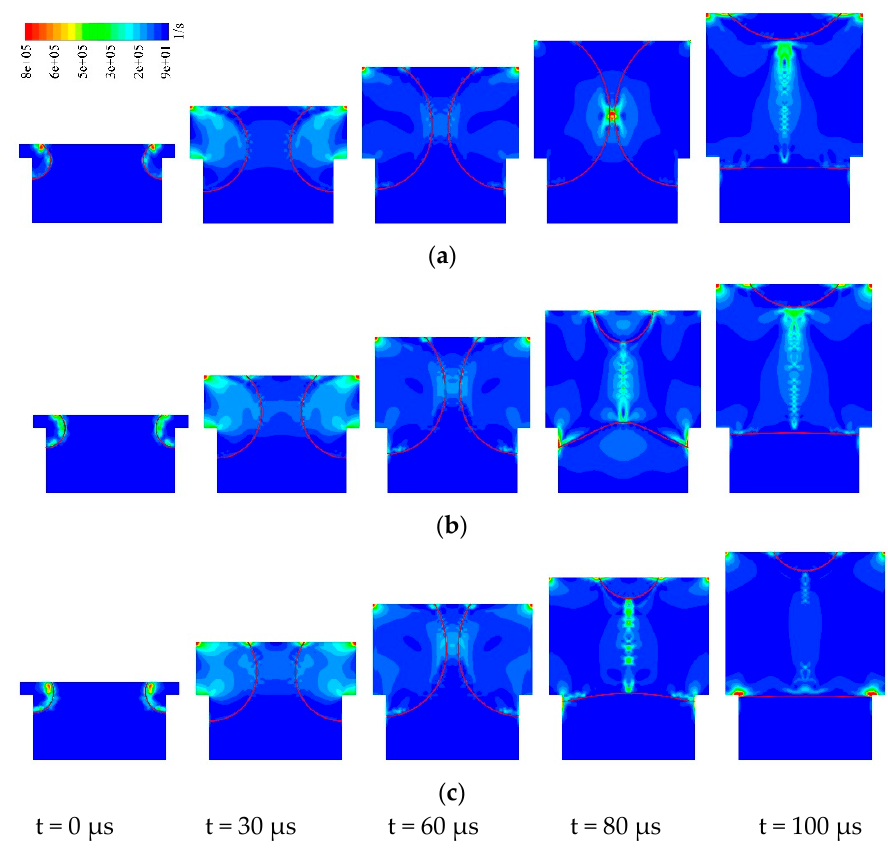
Figure 4. Instantaneous contour of strain rate and contact line under ( a ) α = 30°; ( b ) α = 45°; ( c ) α = 60° (The red line in figure represents the contact line).